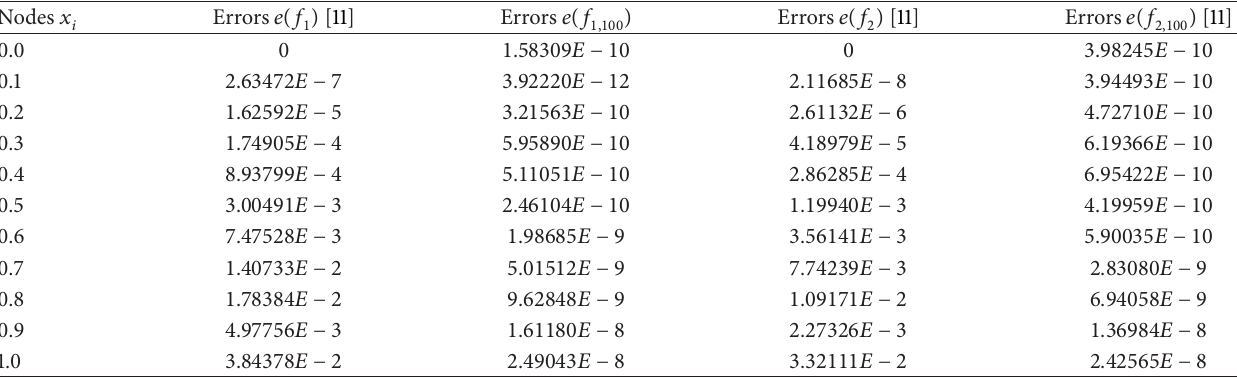
Table 1: Absolute errors for Example 7.